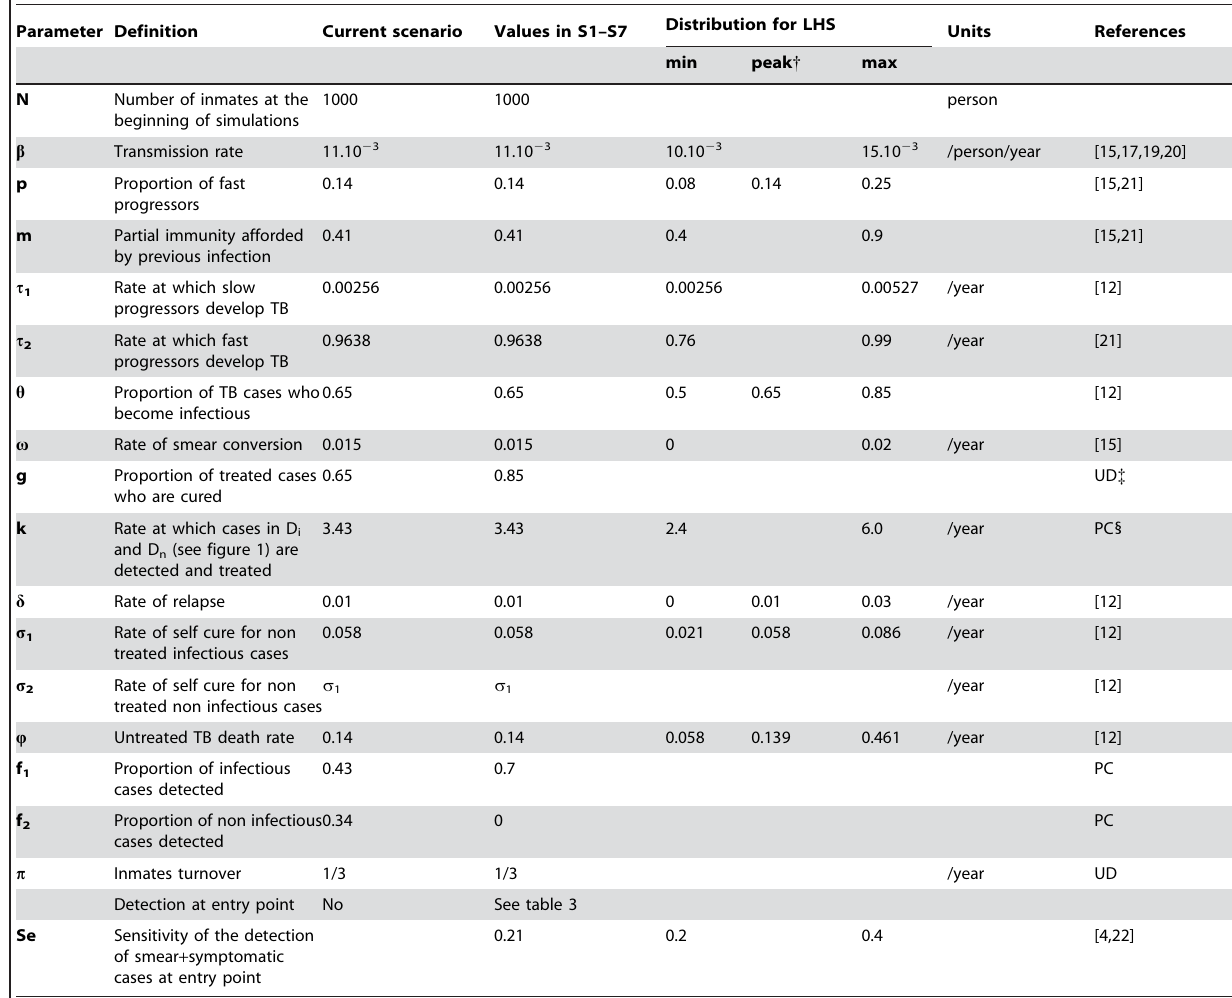
Table 1. Definitions and values of model parameters